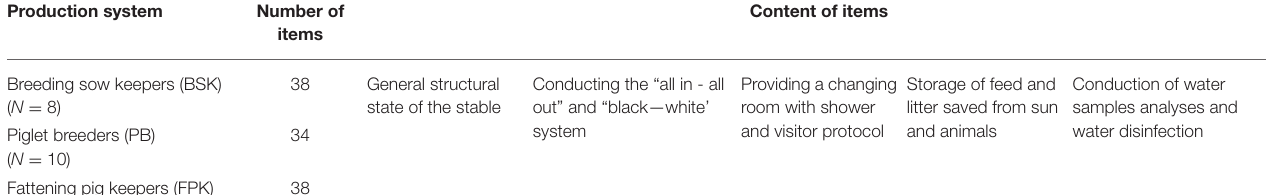
TABLE 4 | Number of items according to the production systems and content examples of items related to the “technical animal hygiene index” (TAHI). Production